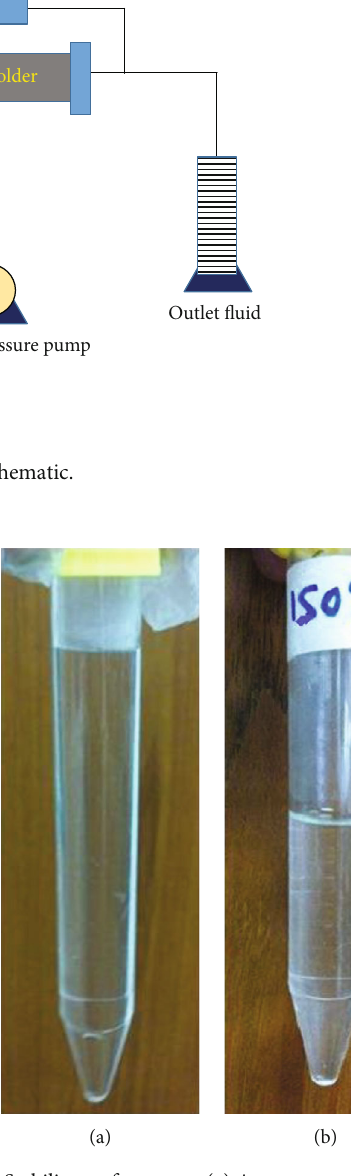
Figure 4: Stability performance. (a) At room temperature. (b) After 24 hours at 150 ° C.